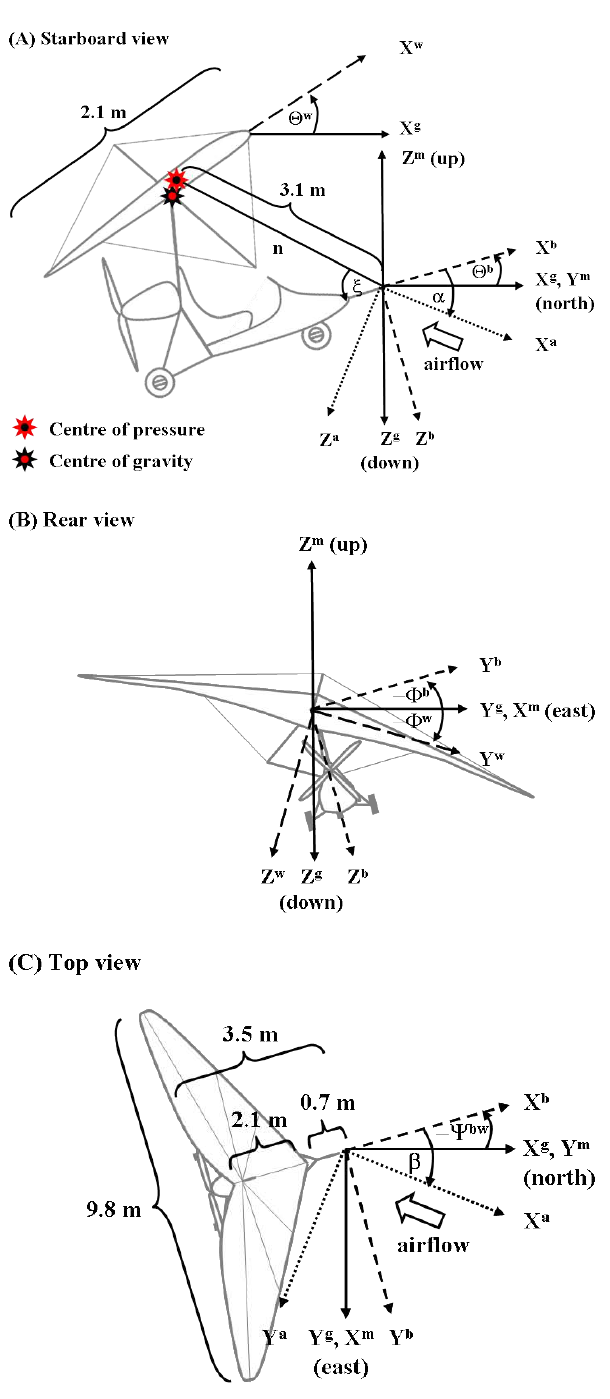
Fig. 2. Geometrical features of the weight-shift microlight aircraft and coordinate systems with axes X, Y, and Z used to compute the wind vector. The superscripts a, b, g, m and w represent, respec- tively, the aerodynamic-, body-, geodetic-, meteorological and wing coordinate systems (Supplement A). (A) Starboard view: Angle of attack ( α ), pitch angle ( 2 ), normalized radius ( n ), wing upwash di- rection ( ξ ), centre of gravity and centre of pressure. (B) Rear view: Roll angle ( 8 ); (C) Top view: Sideslip angle ( β ) and true heading ( 9